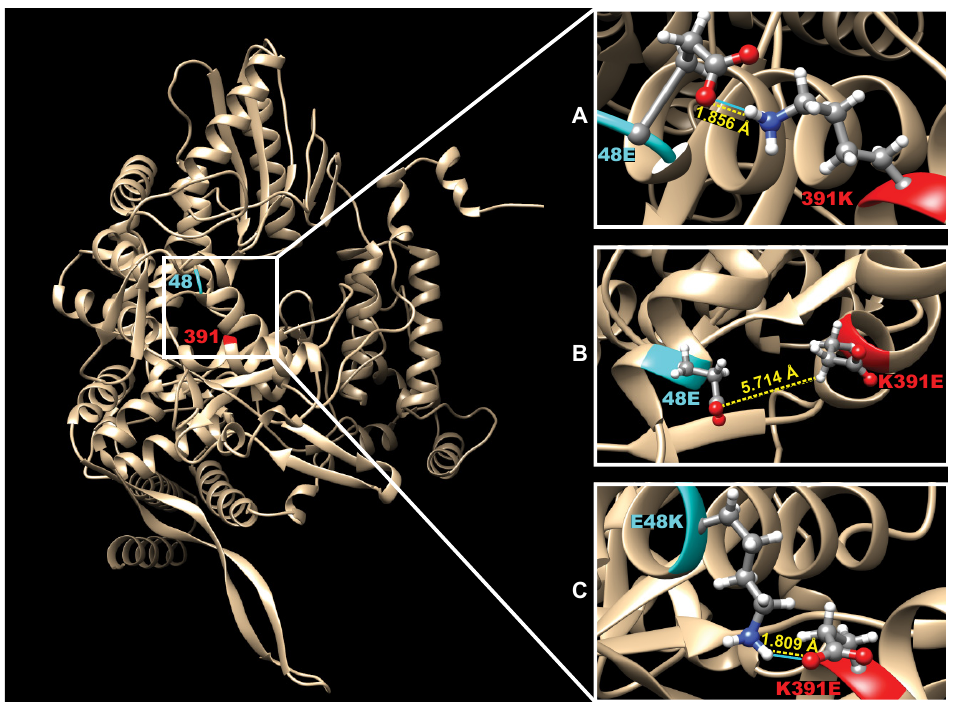
Figure 2. Predicted 3D structure of PB1 showing mutations in residues 48 and 391 and respective molecular interactions between them. Three-dimensional structure predictions using iTASSER of the B/Bris PB1 protein sequence and potential interactions at the interface of amino acids 48 and 391. Blue lines represent the presence of hydrogen bonds. Dotted yellow lines indicate predicted distances in angstroms (Å). ( A ) Potential interaction via a single hydrogen bond and a predicted distance of 1.856 Å between amino acids 48E and 391K in the wt PB1. ( B ) Lack of predicted hydrogen bonds and a predicted distance of 5.714 Å between amino acids 48E and 391E in the PB1 3M protein. ( C ) Amino acids 48K and 391E restore the predicted single hydrogen bond interaction and a distance of 1.809 Å between these two amino acids in the PB1att 4M protein.